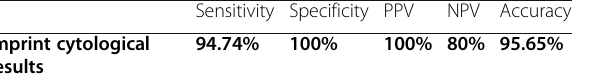
Fig. 5 Imprint cytology for mesothelioma of the pleura